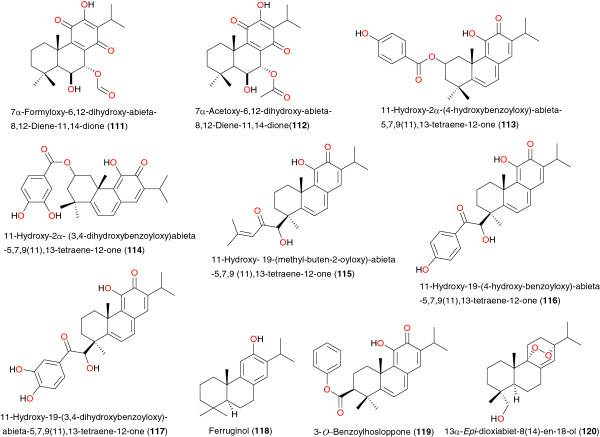
Promising anti-malarial abietane diterpenes from African medicinal plants.